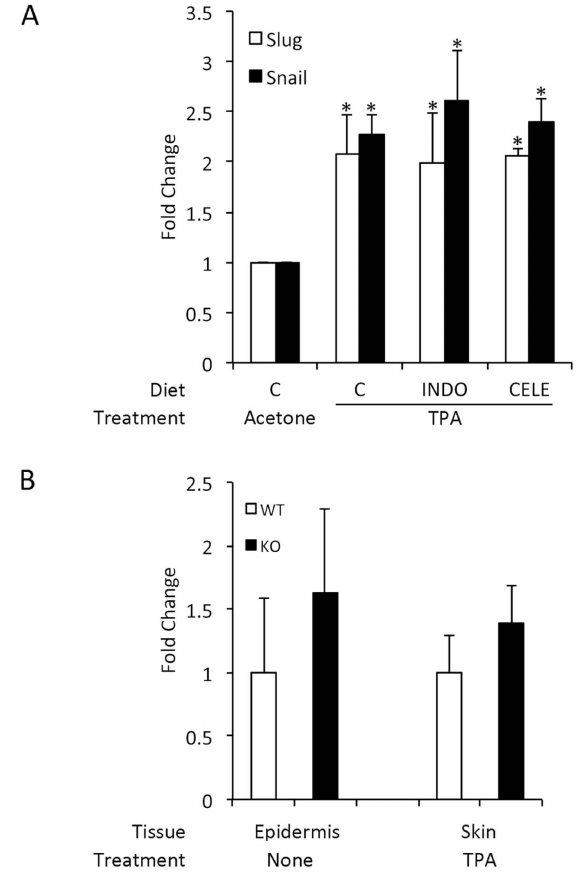
Figure 4. TPA induction of Slug and Snail induction are independent of COX-2 expression. ( A ) Slug and Snail induction in mice fed COX-2 inhibitors. Female FVB mice 6–8-weeks-old were fed a control diet (C) or one containing 4 ppm indomethacin (INDO) or 750 ppm celecoxib (CELE) for one week before application of 2.5 µ g TPA in acetone to the shaved back. Eighteen hours after TPA application, mice were killed, and skin was removed for immunohistochemistry for Slug and Snail. The number of immunohistochemically-positive nuclei per mm was quantified morphometrically. Results are shown as the fold increase compared to acetone-treated skin of mice fed a control diet. Results were compared by ANOVA followed by the Bonferroni correction. * Significantly different from acetone-treated mice fed a control diet, but not different from TPA-treated mice fed any diet. Bars indicate SD. ( B ) PGE2 levels in TPA-treated wild-type and Slug knockout mice. PGE2 levels were determined in the epidermis of untreated wild-type and Slug knockout mice and in whole skin from TPA-treated wild-type and Slug knockout mice harvested 6 h after TPA treatment. In both cases, values in knockout samples were normalized to values in similarly treated wild-type samples. There was no significant difference between wild-type and knockout samples for either comparison when compared by the Mann–Whitney test. Bars indicate